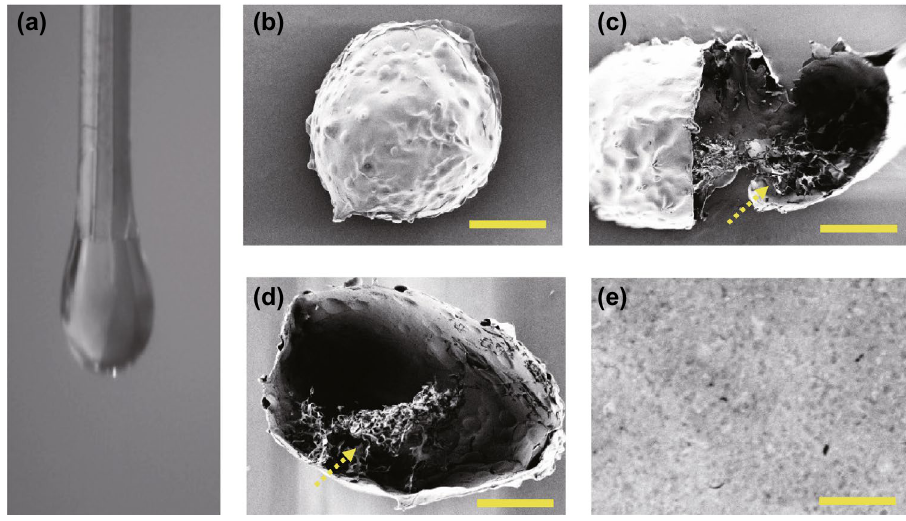
Fig. 2 The preparation of the stem cell-laden core-shell microcapsules. a The real-time image of the microfluidic electrospray process of the microcapsules. b – e Scanning electron microscope images of the whole microcapsule ( b ), the interior of stem cell-encapsulated microcapsules ( c ), stem cells inside the microcapsules ( d ), and the enlarged view of the surface of microcapsules ( e ). The yellow arrow indicates the cells in the microcapsules. Scale bar in ( b , c , and d ) is 100 μm and in ( e ) is 10